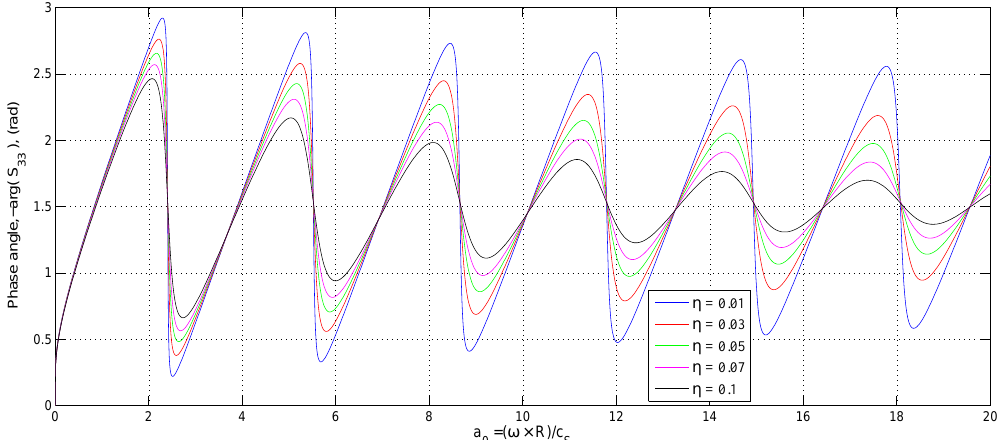
Figure 9. Phase angle of an infinite cylinder due to dynamic vertical load in the axial direction for different values of the loss factor η when loss factor µ = 0.495 and E = 9411 × 10 3 .